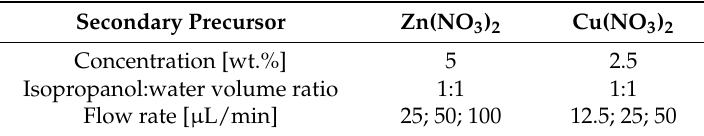
Table 1. Secondary precursor conditions used for the APCVD